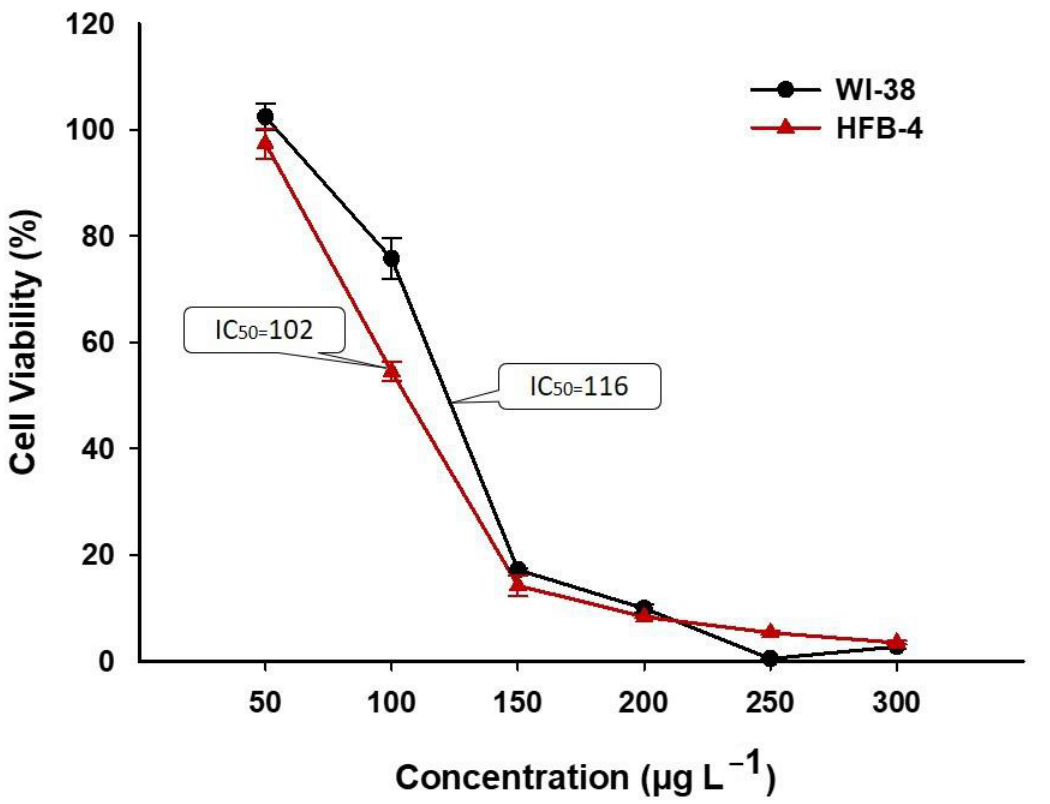
Figure 1. In-vitro cytotoxic efficacy of filter paper loaded with AgNO 3 on normal cell line Wi-38 and HFB-4. Silver nitrate exhibits in vitro cytotoxic efficacy against ovarian (OVCAR-3), breast (MB157), and cervical (HeLa) cell lines with IC 50 35.0, 5.0, and 50 µ M after exposure